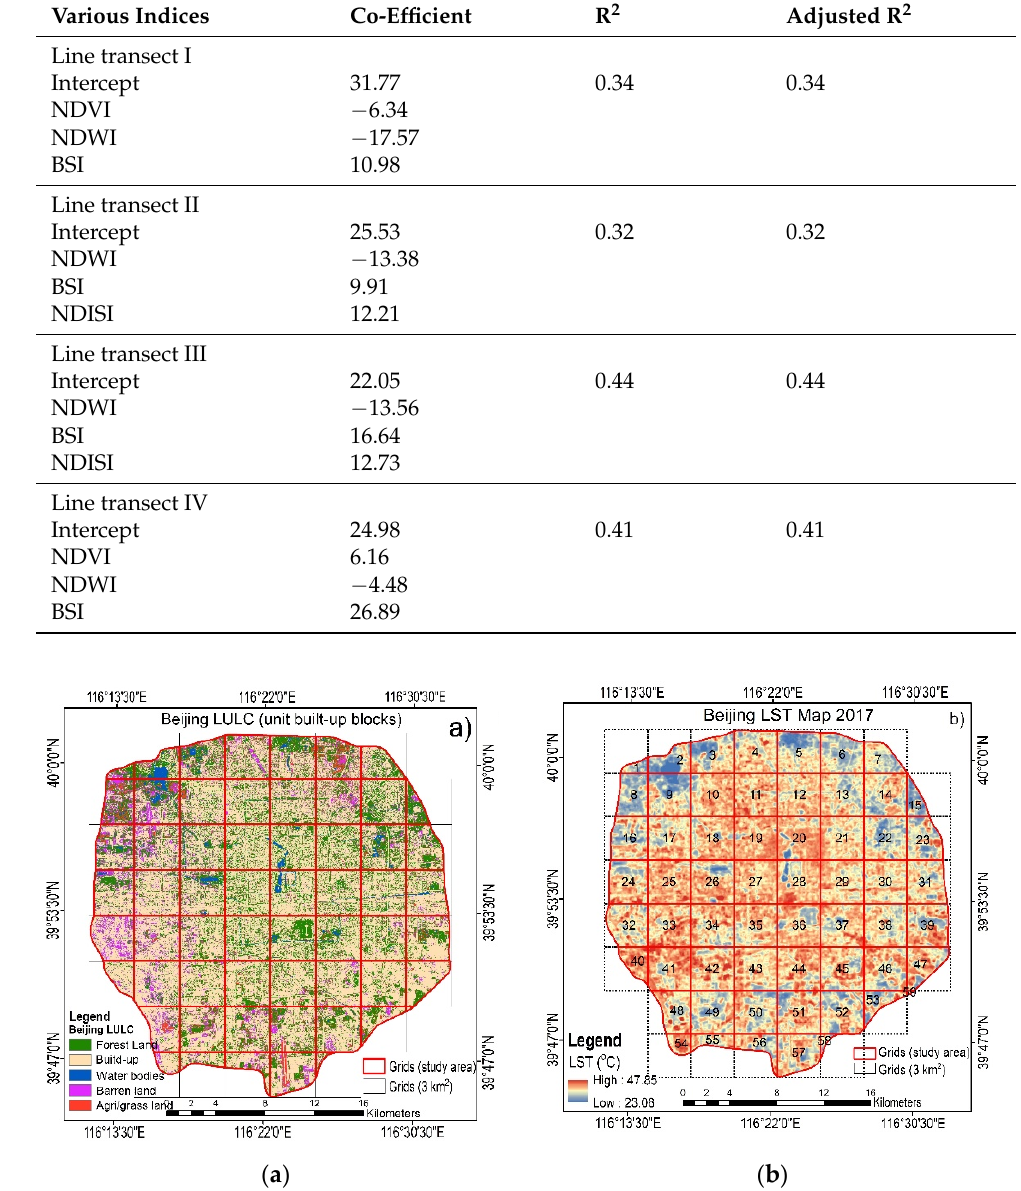
Figure 8. Relationship between ( a ) LULC, and ( b ) LST within the built-up area.